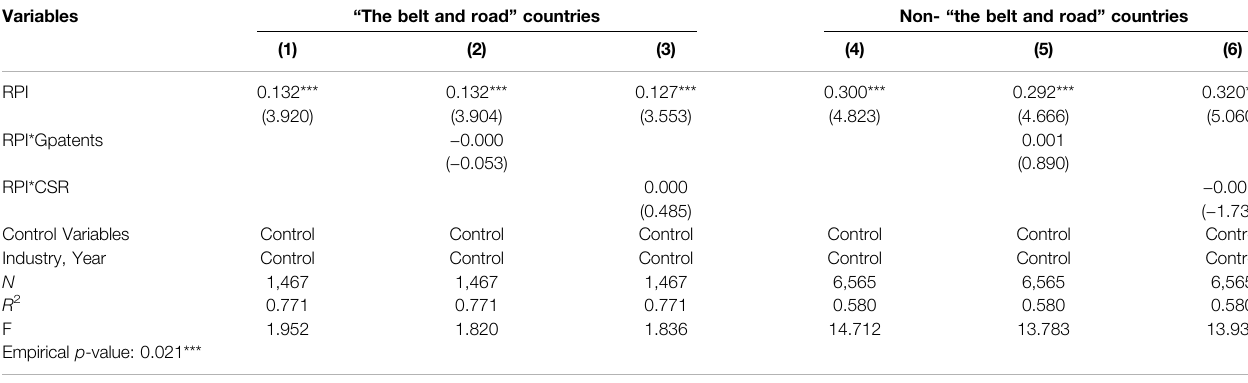
TABLE 13 | Sample regression results of different country types. Variables “ The belt and road ” countries